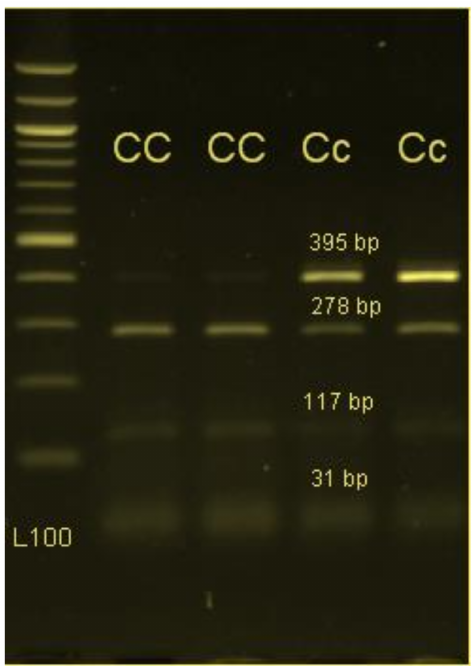
Figure 2. PCR-RFLP results for CLPG gene by BsmFI restriction enzyme on 2% agarose gel. PCR products produced segments of 395 bp and 31 bp for mutant allele c and 278 bp, 117 bp, and 31 bp for wild type allele C.